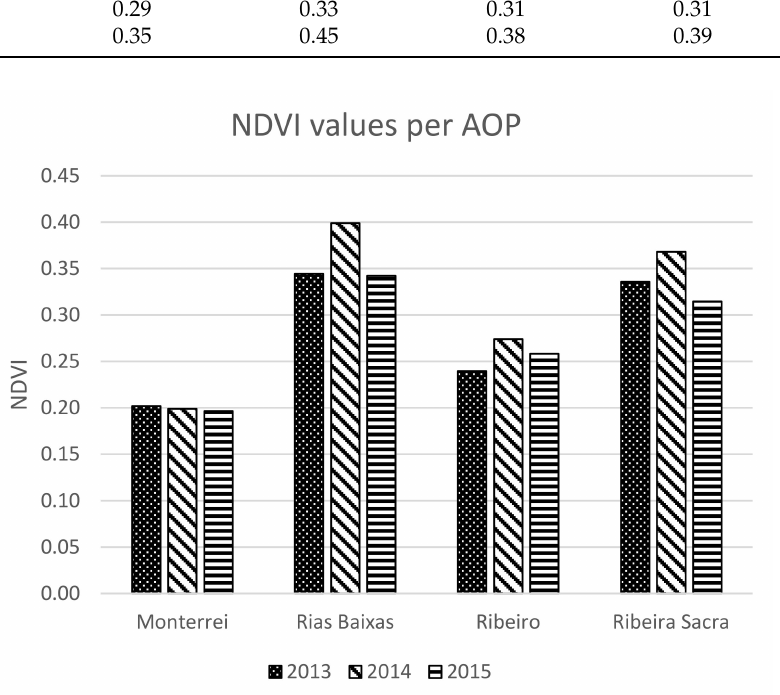
Figure 3. NDVI values per AOP calculated using Landsat imagery close to veraison. Years 2013, 2014, and